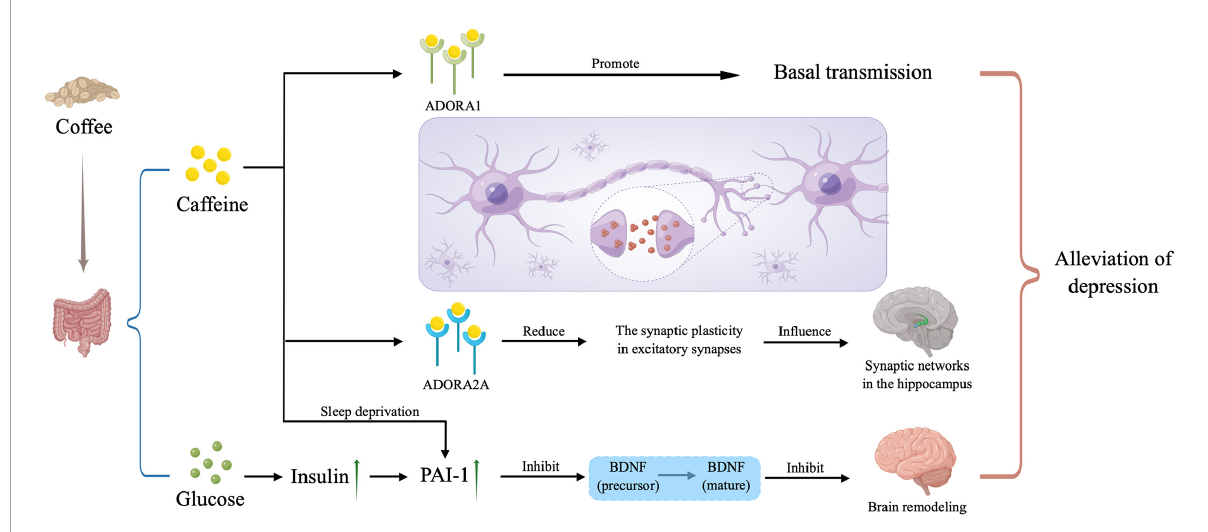
FIGURE4 Potential mechanisms. Caffeine plays a role in the depression alleviation by combining with ADORA1 and ADORA2A to influence our neural network in the brain, and inhibiting the mature of brain-derived neurotrophic factor (BDNF), and the latter way can also be triggered by large amounts of sugar taken in with caffeine when drinking coffee. PAI-1, plasminogen activator inhibitor; ADORA1 , adenosine A1 receptor; ADORA2A , adenosine A2A receptor. The picture was drawn by